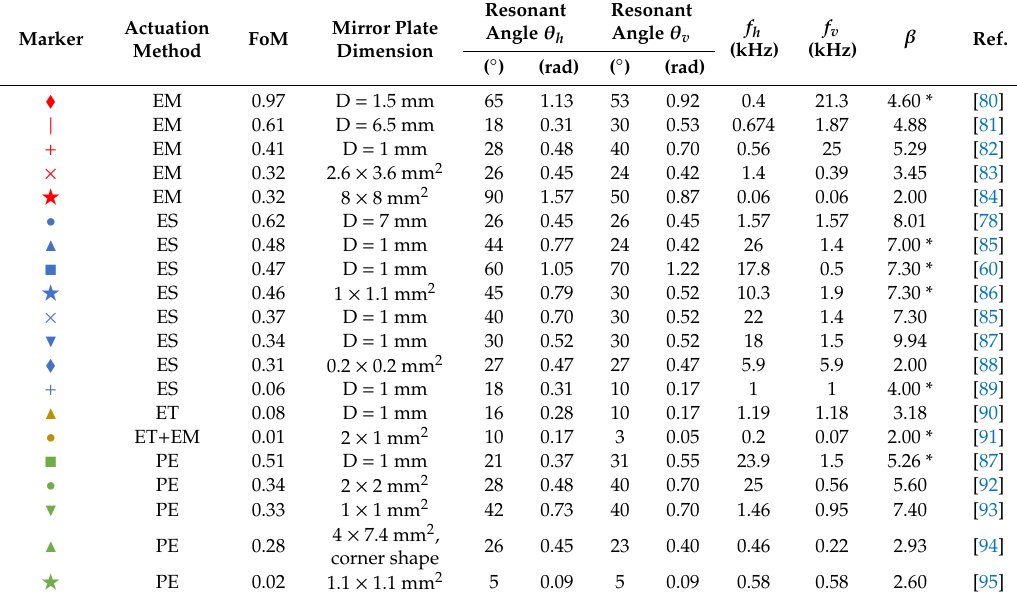
Table 4. The FoM of 2D double resonant scanning MEMS